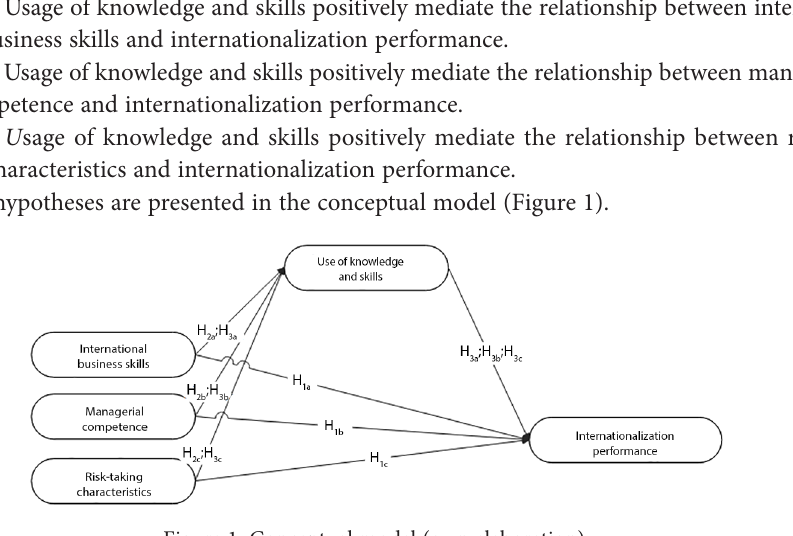
Figure 1. Conceptual model (own